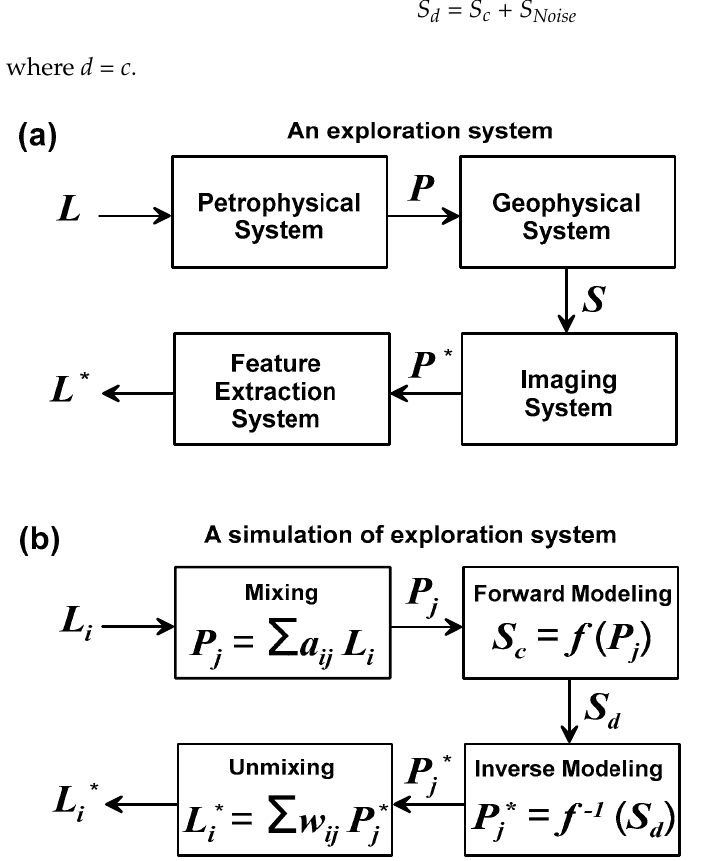
Figure 1. Workflow of geological feature extraction: ( a ) An exploration system: The synergy of the hidden mixing petrophysical system with the geophysical system creates observed geophysical signals ( S ) that produce measured physical properties ( P ). The approximated physical properties ( P * ) are used in a feature extraction system to recover the hidden geological factors ( L ). ( b ) A simulation of the exploration system: Synthetic geophysical signals ( S d ) are calculated from the forward responses of the simulated physical properties ( P j ) that are linear mixtures of hidden geological features ( L i ). Multiple inversions calculate the estimated physical properties ( P j * ) that are used in the subsequent feature extractions to retrieve an approximation of the latent lithotypes ( L i * ).